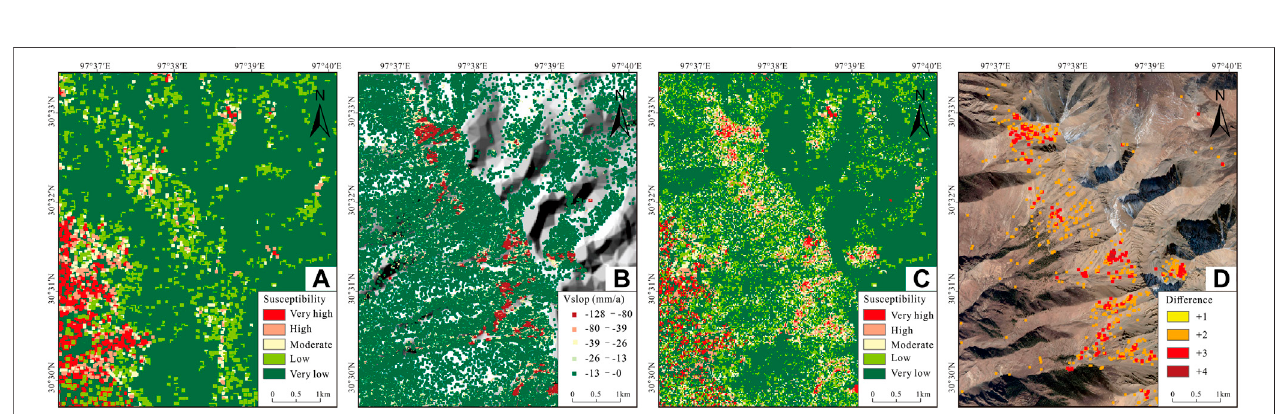
FIGURE 10 | Landslide assessment results of area No. 1 (Ritong area). (A) landslide susceptibility assessment results obtained using the FR-RF model. (B) deformation rates in the slope direction obtained by the SBAS-InSAR method. (C) optimized landslide susceptibility assessment results. (D) changes in landslide susceptibility grades before and after re fi ning.